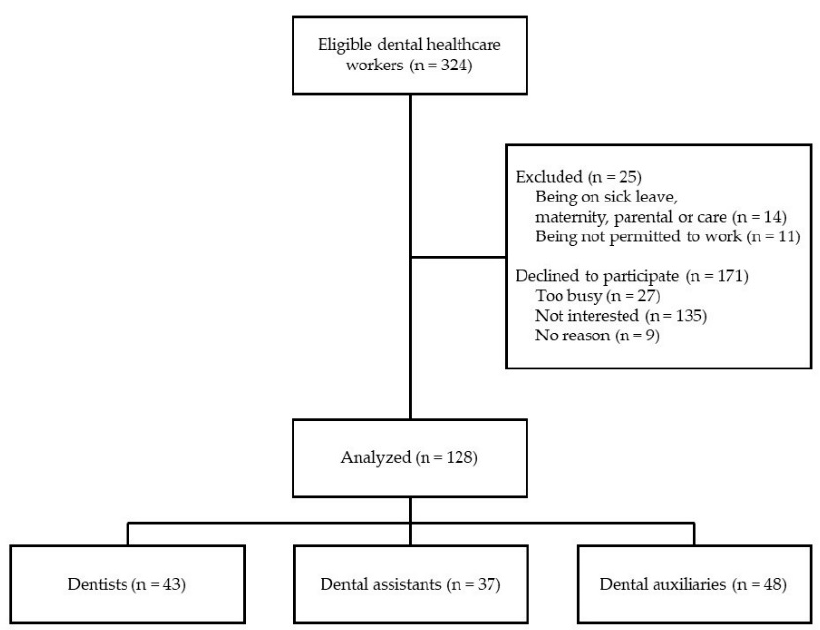
Figure 1. Flow diagram for study participants.